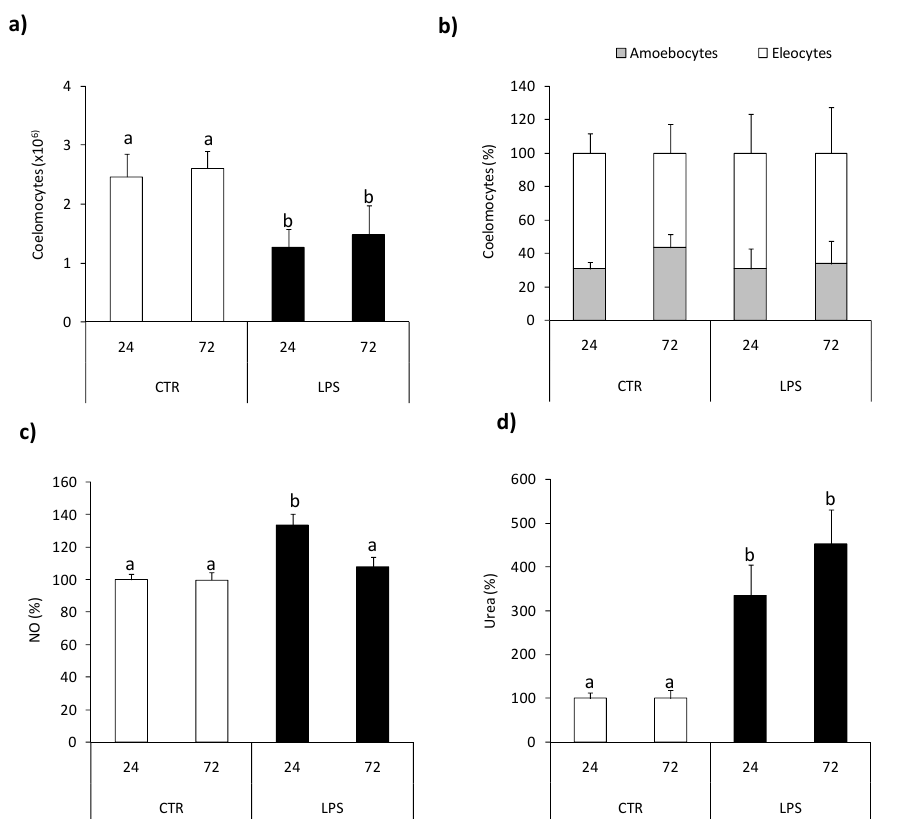
Figure 4. Effects of in vivo stimulation with lipopolysaccharide on arginase activity and nitric oxide production in Eisenia andrei coelomocytes. Coelomocytes were collected 24 or 72 h post earthworms injection with 0.9% sodium chloride (CTR) or with LPS (1 mg/mL). Number ( a ) and composition ( b ) of coelomocytes was counted. Nitric oxide (NO) production ( c ) and arginase activity ( d ) are showed as % of control (NO production and arginase activity in coelomocytes of CTR animals = 100%). Mean + SE, n = 8. Mean values that are significantly different are not assigned a common letter (e.g., a vs. b or b vs. c) according to one-way analysis of variance (ANOVA) (at p < 0.05).